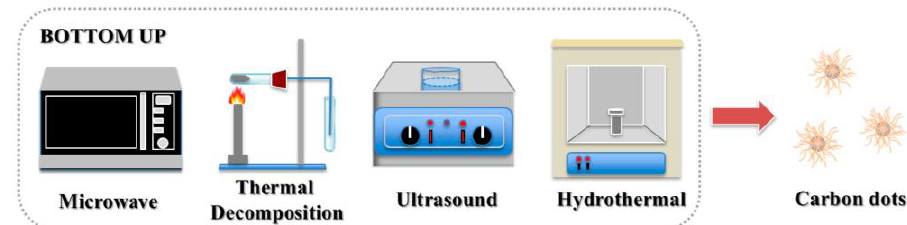
Figure 4. Bottom-up synthesis of CDs